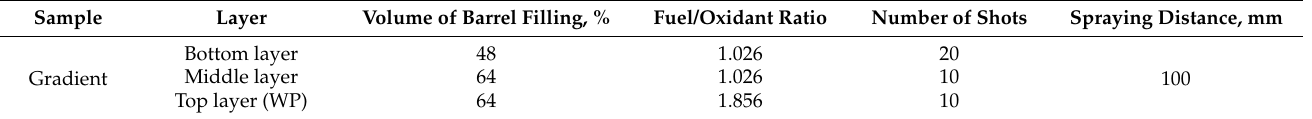
Table 3. Technological parameters for obtaining coatings with a gradient